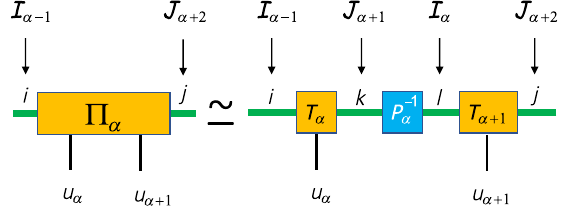
FIG. 5. Pictorial representation of the Π α tensor and its cross interpolation. The notation is the same as in Fig.